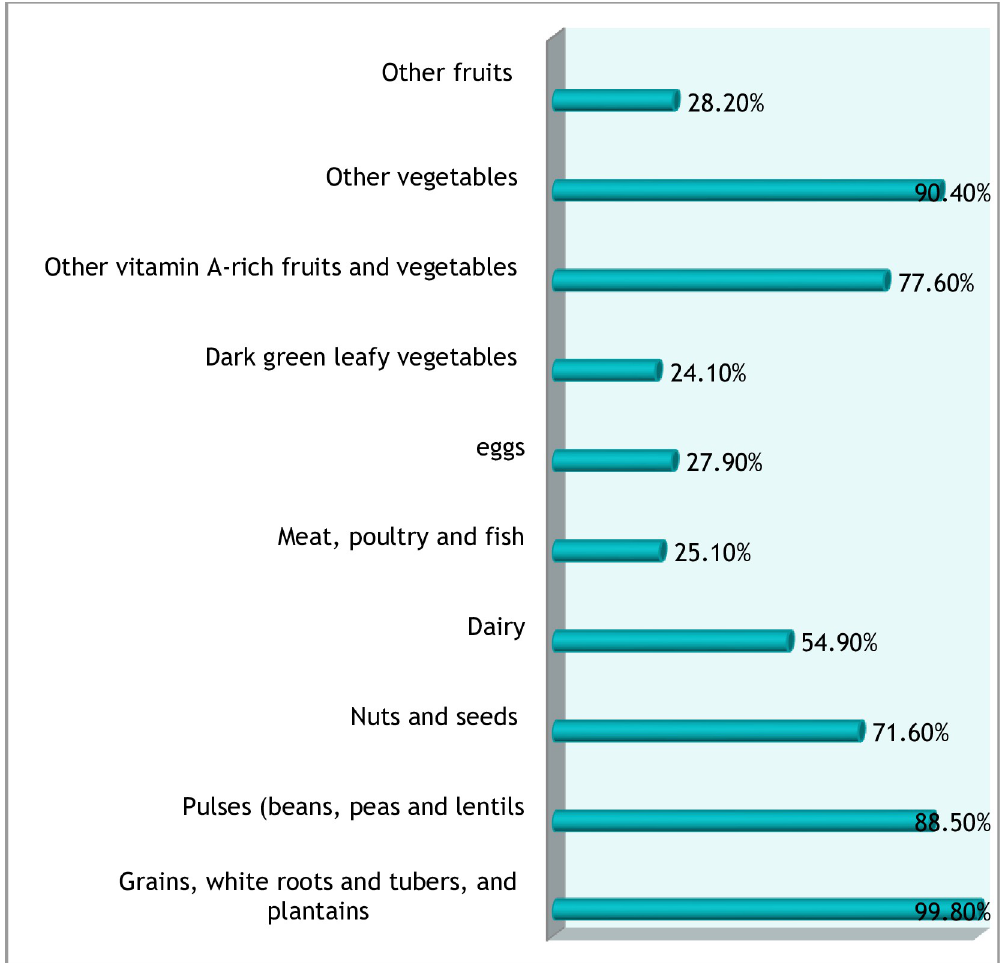
Fig 1. Food groups consumed among women reproductive age in Jeldu West Shoa Zone Ethiopia, 2018.